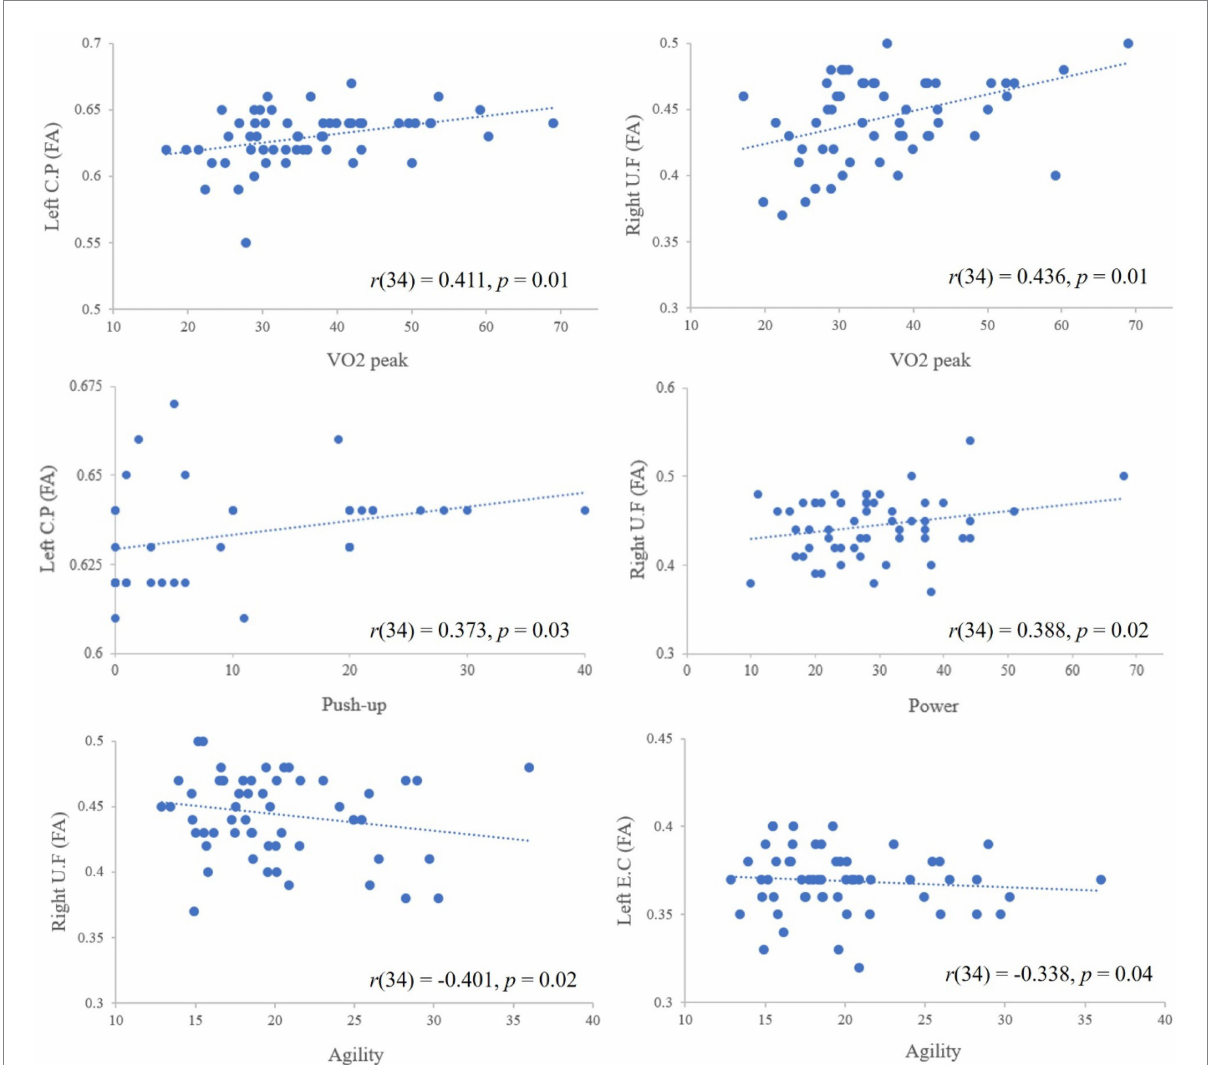
FIGURE 3 The correlations between physical fitness measurements and FA value. The dotted lines represent the trend lines (i.e., positive, negative trend) and the negative sloped trendlines were appeared between agility and FA values because agility was determined by T test (lesser time represents greater agility ability); CP, cerebral peduncle; UF, uncinate fasciculus; EC, external